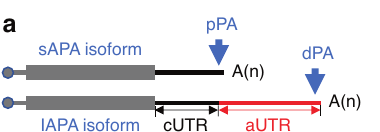
bone/cartilage development inducer bone morphogenic protein 5 (Bmp5) (Table S7). These results indicate that thousands of genes are expressed as multiple APA isoforms in the callus and suggest critical roles of APA in bone regeneration. Utilization of the pPA generates shortened 3 ′ UTRs in the Col1a1 and Col1a2 transcripts Type I Collagen, which is the main component of the organic bone matrix, is a heterotrimer comprising two α 1 chains (encoded by Col1a1) and one α 2 chain (encoded by Col1a2). 30 According to our RNA-seq data analyses, Col1a1 and Col1a2 are the most abundant transcripts in the d14 callus, and both are expressed as 2 main APA isoforms (Fig. 3a and Tables S4, S5, S7). To con fi rm these results, we mapped the 3 ′ end of both the Col1a1 and Col1a2 mRNAs by performing rapid ampli fi cation of cDNA 3 ′ ends (3 ′ RACE) (Fig. S8a,